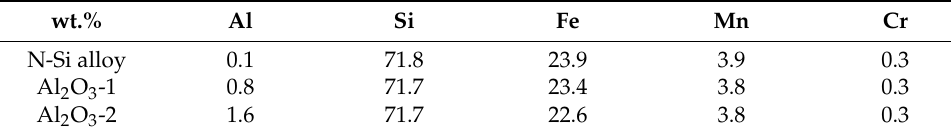
Figure 3. Particle distribution curve of the powders: ( a ) N-Si alloy, ( b ) Al 2 O 3 -1, and ( c ) Al 2 O 3 -2. Table 3. Composition of each powder sample as evaluated by XRF.